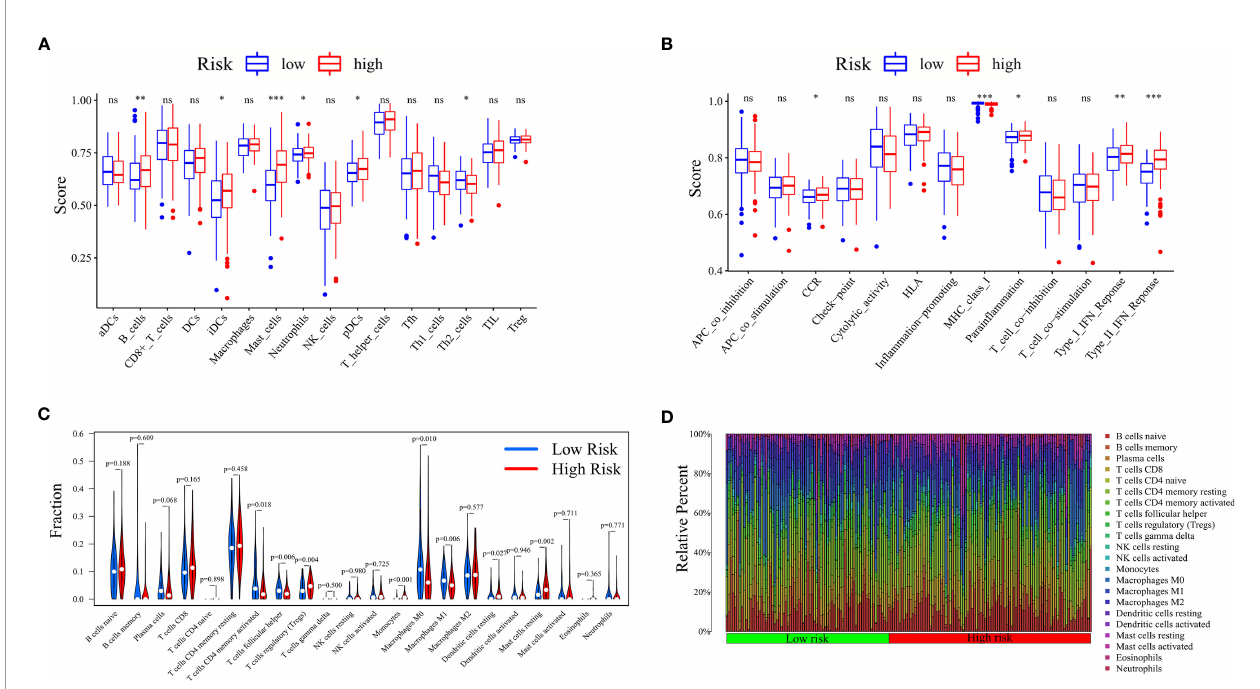
FIGURE 6 | Analysis of immune cell in fi ltration between high- and low-risk groups. Risk differential analysis of (A) immune cells and (B) immune-related pathways based on ssGSEA. (C) Violin plots showing the content difference of multiple immune cells between high- and low-risk groups based on the CIBERSORT algorithm. (D) Histogram showing the composition of the immune cells of each sample in the high- and low-risk groups based on the CIBERSORT algorithm. ssGSEA, single- sample gene set enrichment analysis. ns, not signi fi cat; *P < 0.05; **P < 0.01; ***P <